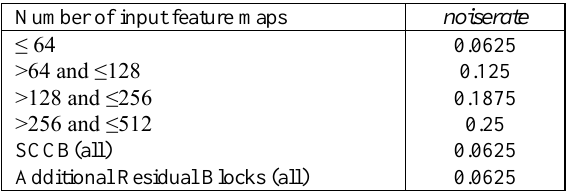
Table 2. noiserate used during training